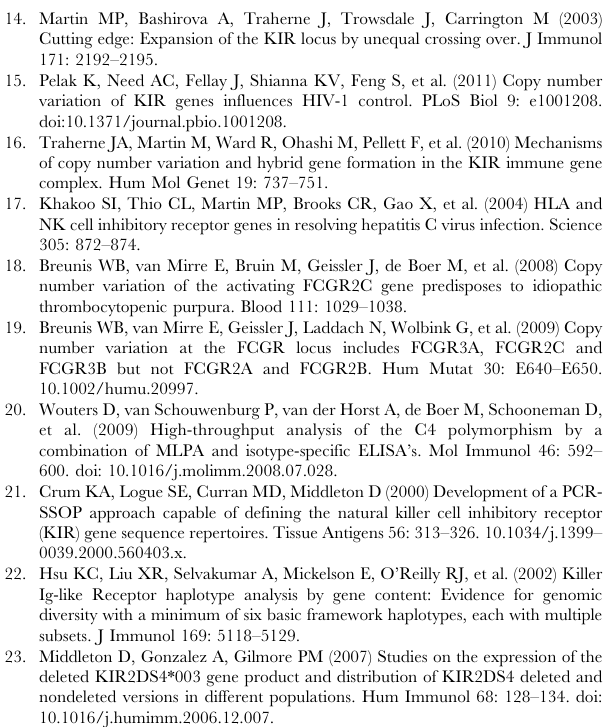
Figure S3 KIR gene pedigree analysis of an Israeli family by KIR MLPA. Both parents carry only one copy of the framework genes KIR3DP1 and KIR2DL4 , which results in a complete absence of those genes in all three children. Figure S4 Graphical representation of the quantitative PCR on DNA from Centre d’Etude du Polymorphisme Humaine family 1347 and some control donors. (A) The relative product of KIR2DL5 compared to the occurrence of CYBB (corrected for sex). (B) The relative product of KIR2DS3 compared to the occurrence of CYBB (corrected for sex). Table S1 Overview probe sequences of the KIR MLPA technique. Table S2 Overview control probe sequences of the KIR MLPA technique.